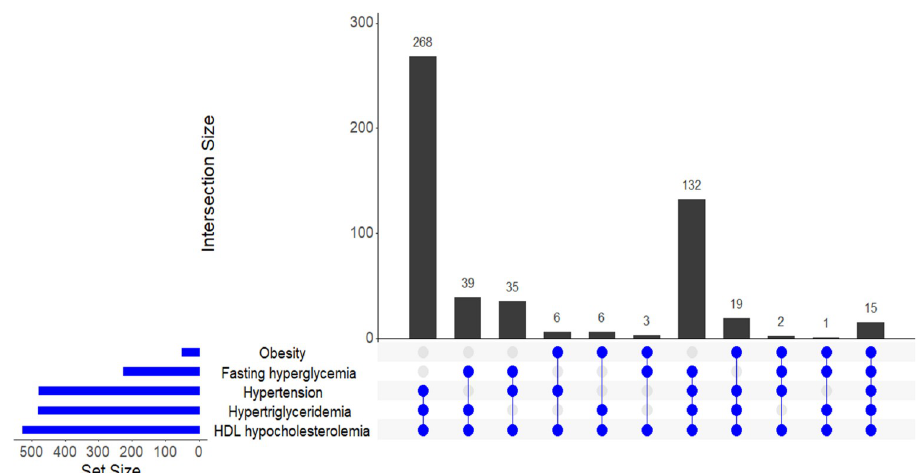
Fig 1. Frequency of combinations of metabolic abnormalities among people living with HIV with metabolic syndrome on follow-up between 2015 and 2017’.